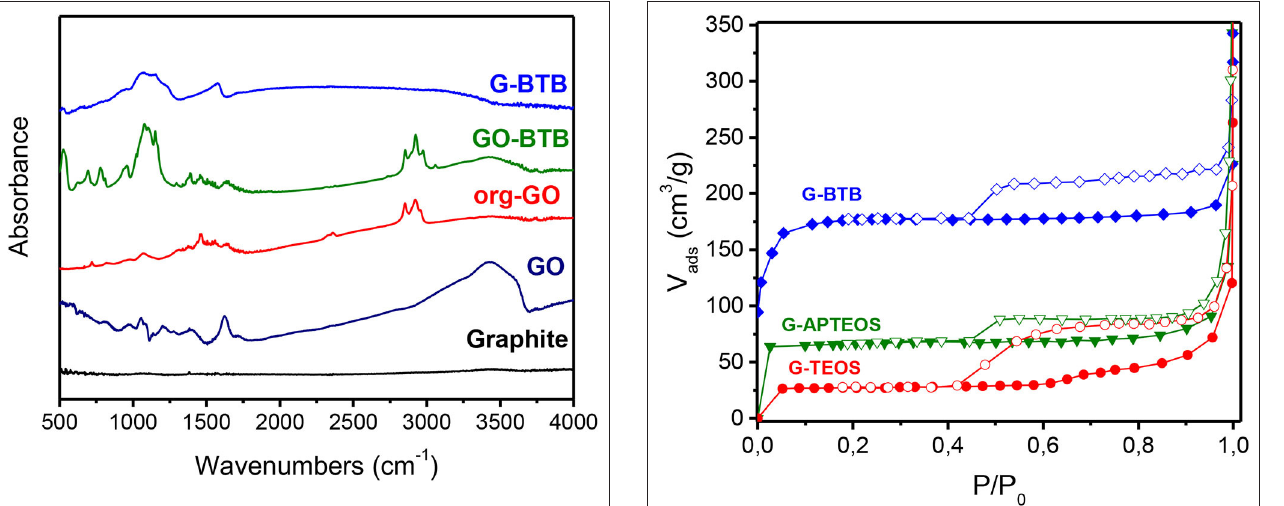
The sol-gel reactions were performed at 50 ◦ C while stirring, and the obtained gel was placed in the oven at 50 ◦ C overnight.